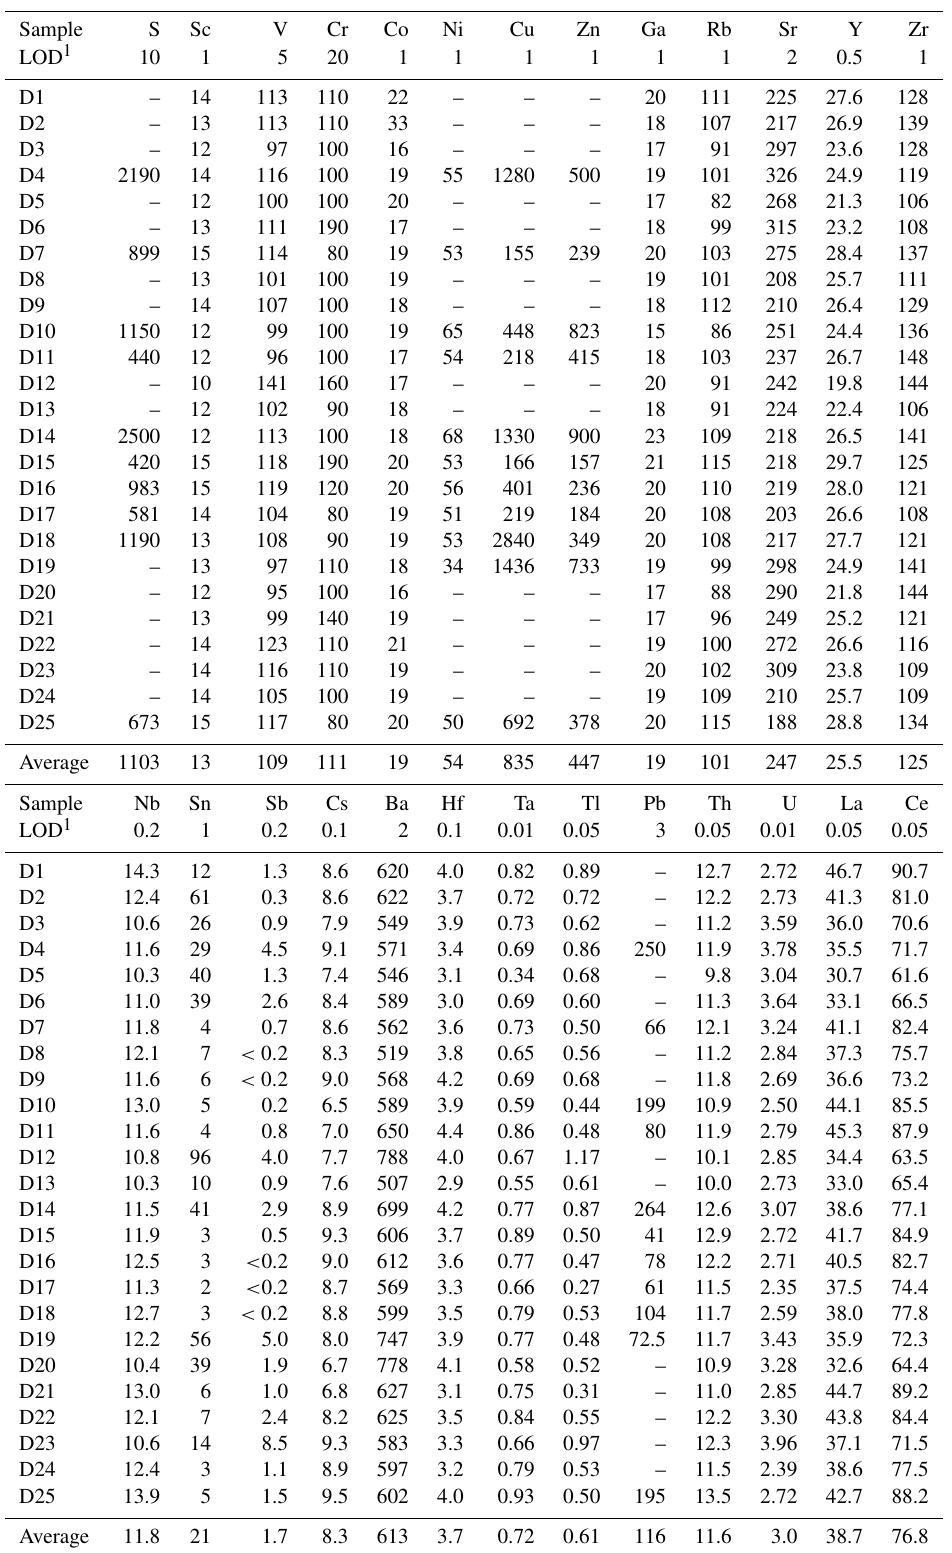
Table 4. Trace element composition of Asian dust (in ppm).